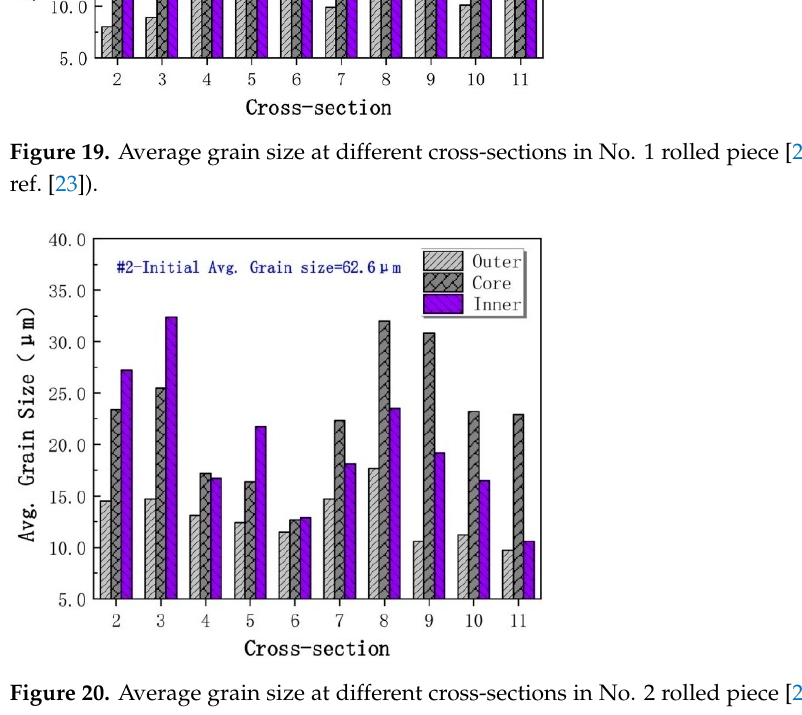
( b ) Figure 21. Schematic diagram of the rotary piercing process: ( a ) front view; ( b ) top view [24] (Re- printed from ref. [24]). Compared with the traditional machining hollow axle bore, the rotary piercing pro- cess has the following advantages: Since the step of cutting the inner hole is omitted, this process can reduce steel consumption and save about 100 kg of materials. The rotary pierc- ing reduces the difficulty of machining and saves the cost of boring. The tube rolled by this process is more compact, the fiber flows along the rolling direction, and the main working stress is perpendicular to the fiber distribution direction, which is conducive to improving its working stress and fatigue life. Yuanrui et al. obtained 35CrMo super-thick-wall seamless steel pipes of a certain size with a Pilger mill. After analyzing the metallographic structure and mechanical properties and conducting other tests on the seamless steel pipes, it was confirmed that the quality of this batch of steel pipes met the technical requirements for hollow axle blanks [25]. Romanenko et al. studied the method of preparing hollow axle blanks for railway vehicles